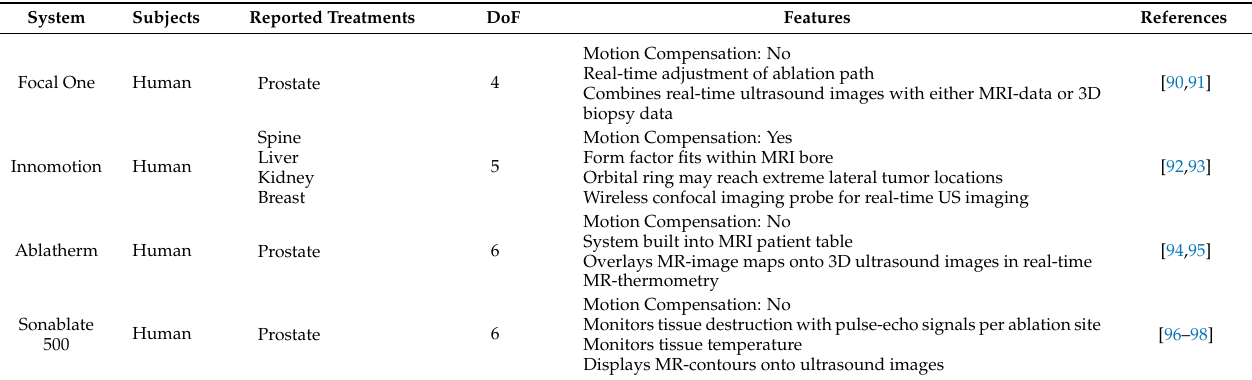
Table 3. Overview of Multi-Modal Image-Guided HIFU